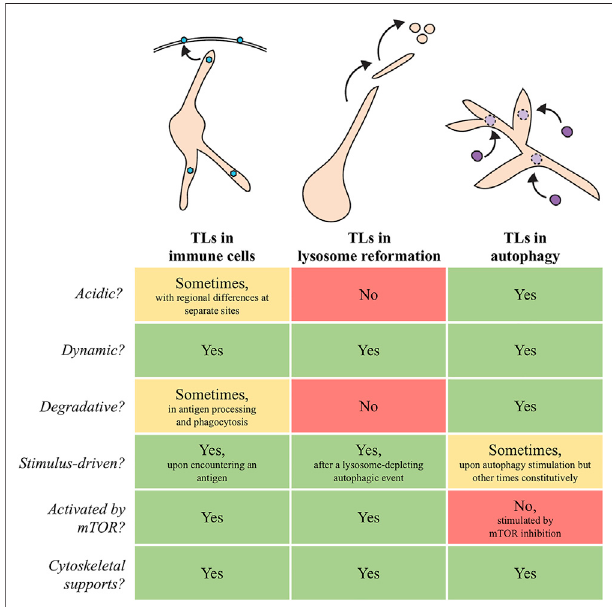
FIGURE 1 | Schematic models and summary of similarities and differences between TLs in immune cells, lysosome reformation, and autophagy. Blue hexagons in immune cells: antigens. Purple circles that dock and fuse with autophagic TLs: